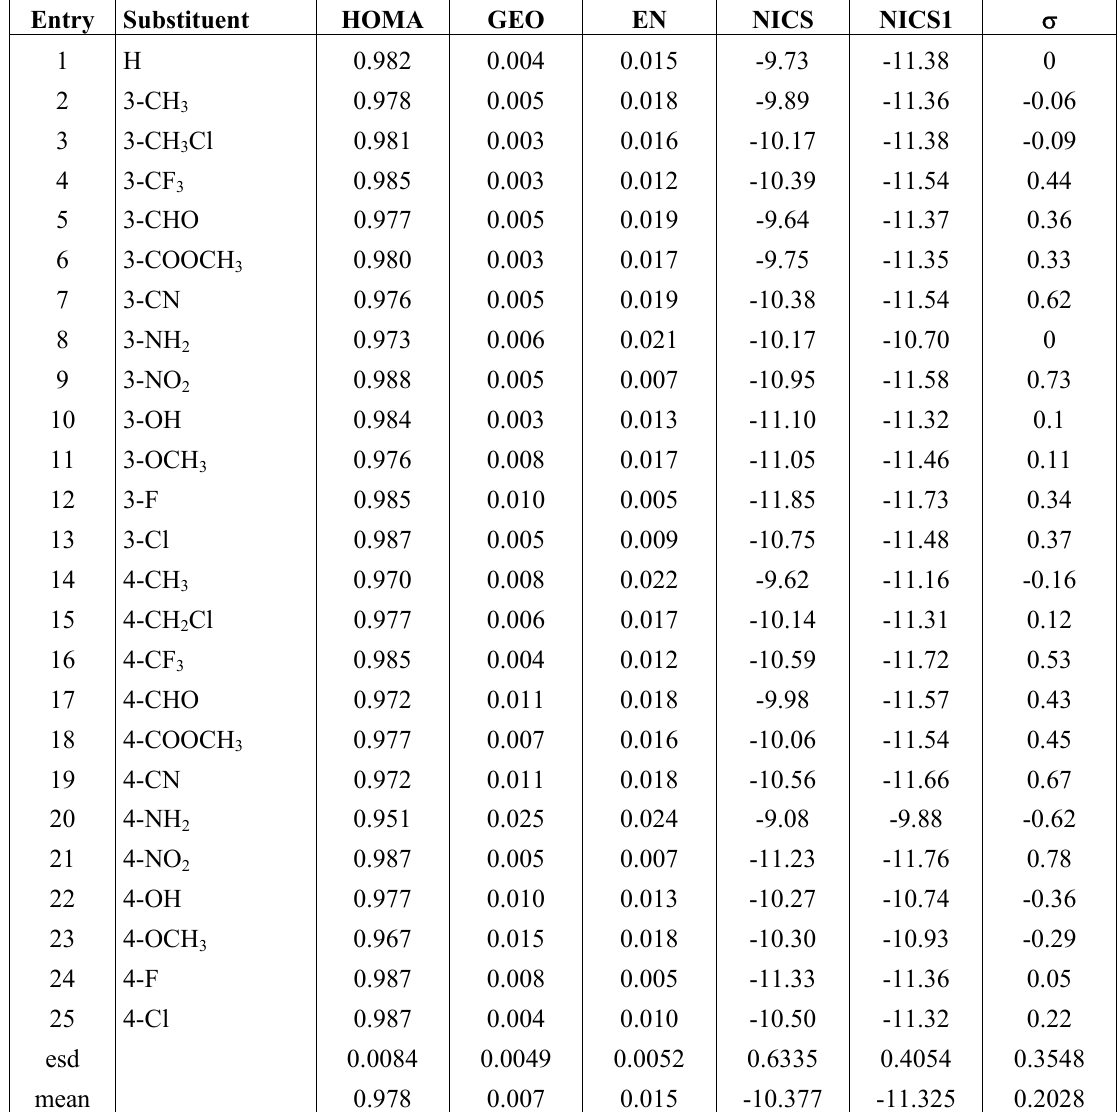
Table 1. Computation of HOMA, EN, GEO, NICS and NICS(1) for 25 meta – or para – derivatives of benzoic